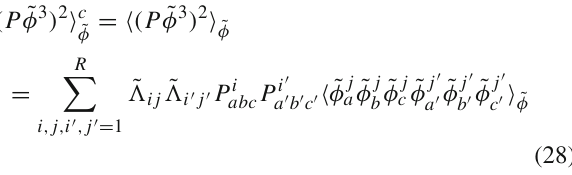
(cid:9) ˜ (cid:8) R φ j i ij P a i , j = 1 abc